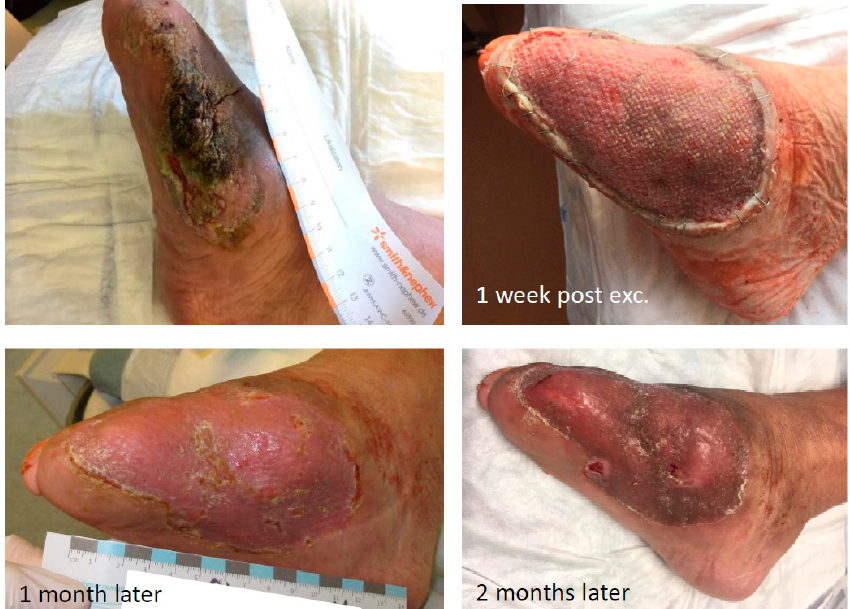
Figure 8. Pre- and post-op. findings.